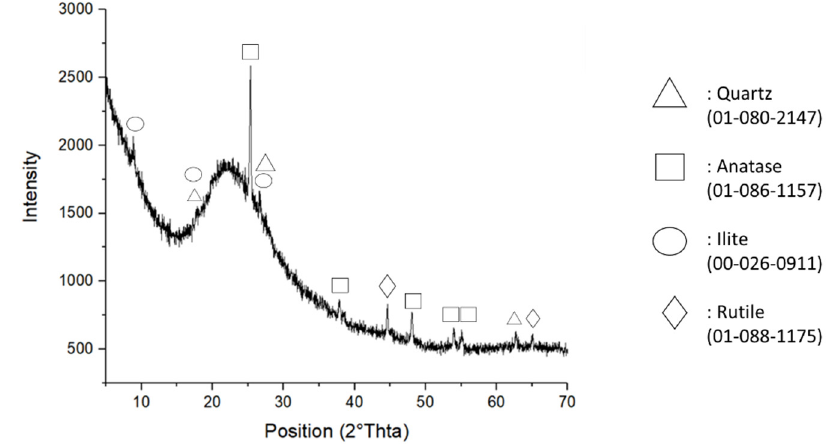
Figure 1. XRD pattern of the as-received white metakaolin powder.